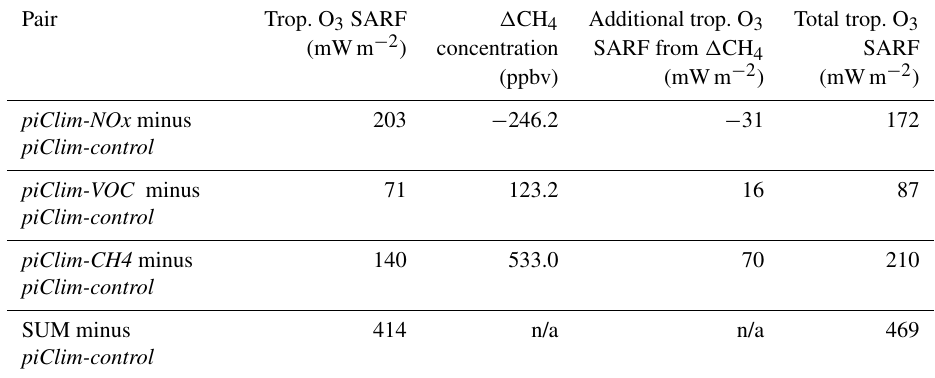
Table 5. Contribution to the tropospheric O 3 SARF from the different perturbation experiments ( piClim-NOx , piClim-VOC , and piClim- CH4 ) relative to the pre-industrial control ( piClim-control ). Also shown is the absolute difference between the equilibrium and prescribed CH 4 concentrations in the different experiments and the resulting additional contribution to the total tropospheric O 3 SARF from the CH 4 - driven response in O 3 .